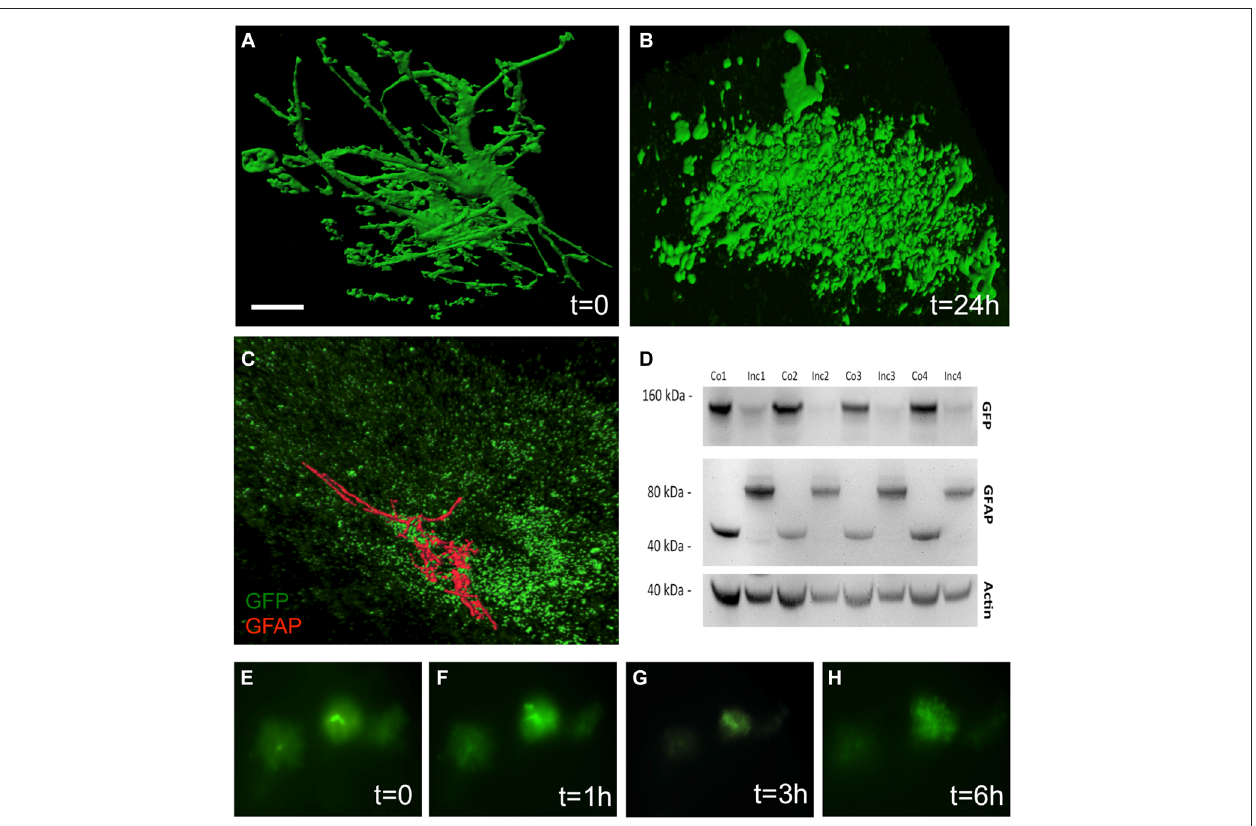
FIGURE 3 | Clasmatodendrosis in cultured astrocytes of 12 month old APP-SweDI × GFP-GFAP mice. Healthy astrocytes were detected in 110 µ m vibratome brain slices immediately fixed after sectioning. Note the distinct processes and arborization (A) . However, 24 h after culturing cells dramatically changed their morphology resulting in the loss of distal processes as well as the generation of isolated fluorescent bodies with no connection to the former cell (B) . Some clasmatodendritic cells still showed the presence of a few slight glial fibrilllary acidic protein (GFAP) + branches (C) . Western blot analysis revealed a decrease in GFP, whereas the GFAP protein was enhanced in size after 24 h of culturing (D) . Size marker are given in kDa. In vitro live cell imaging shows that many GFP + cells degenerate already within 3 h of culturing (E–H) . Scale bar = 5 µ m (A,B) , 7 µ m (C) , 40 µ m (E–H)